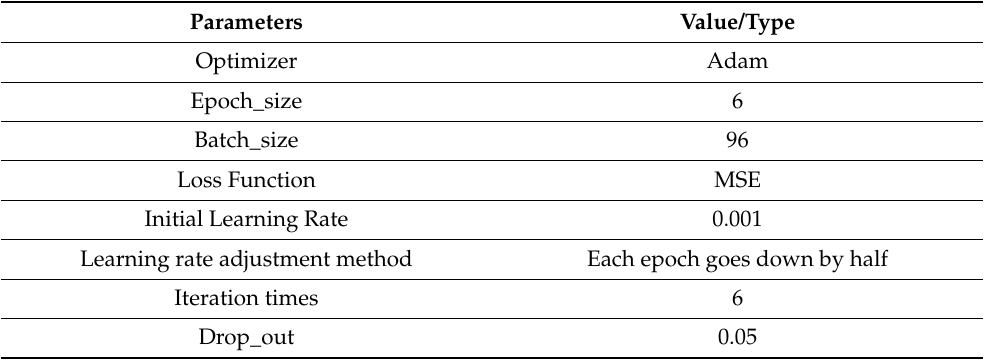
Table 4. The Training parameters for the Informer